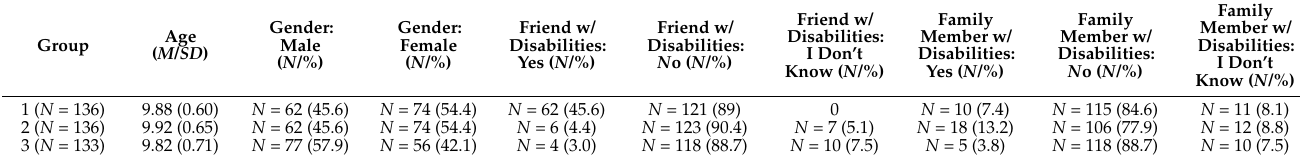
Table 1. Sample characteristics (depending on the experimental group).